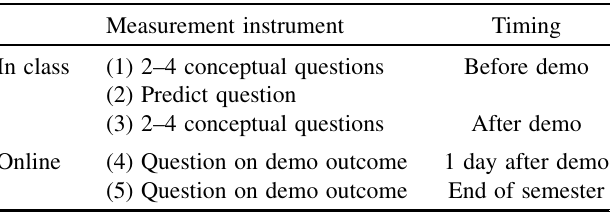
TABLE I. Summary of the data collection procedure. Measurement